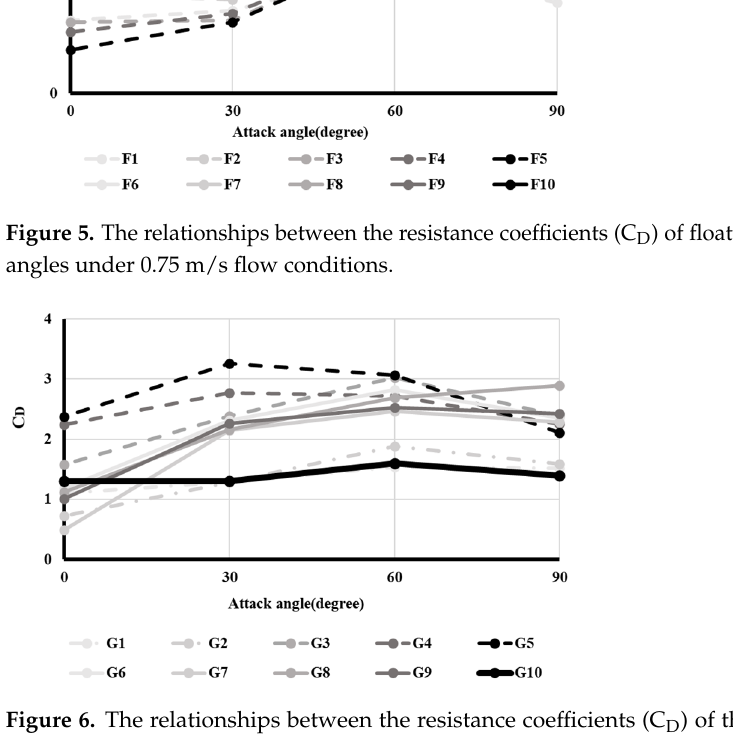
Figure 6. The relationships between the resistance coefficients (C D ) of the different ground gears (G1–G10) and their attack angles under 0.75 m/s flow conditions.